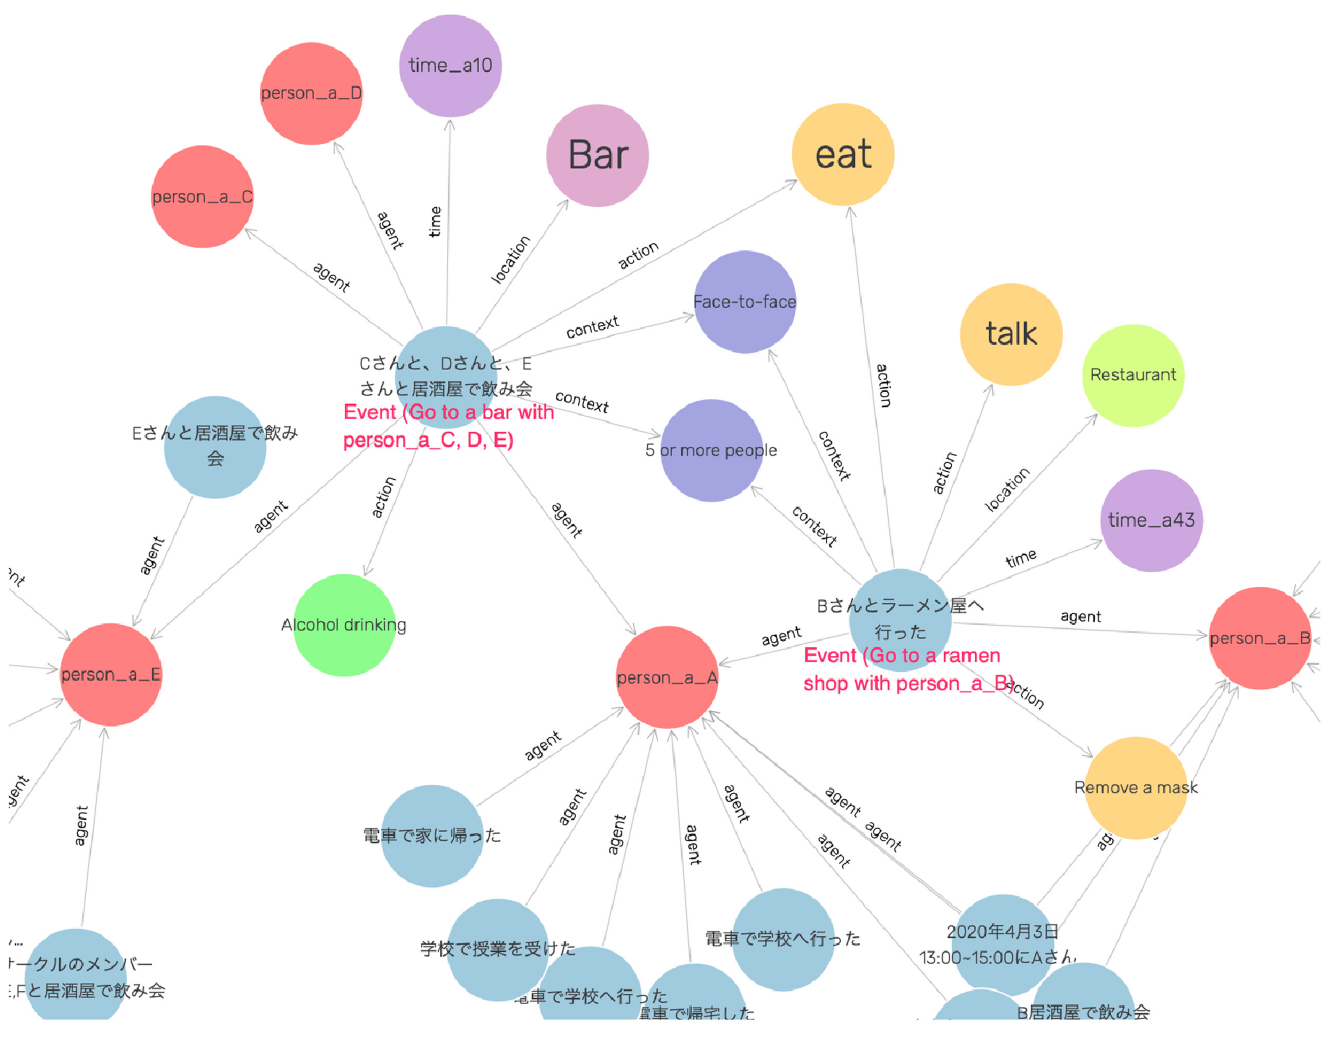
Fig 7. Examples of knowledge graph